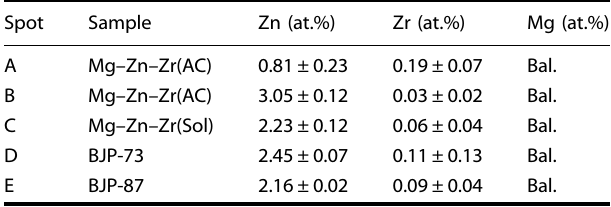
Elemental composition of the matrix of the cast and BJP Mg – Zn – Zr magnesium alloy as determined from EDX, reported with respective standard deviation